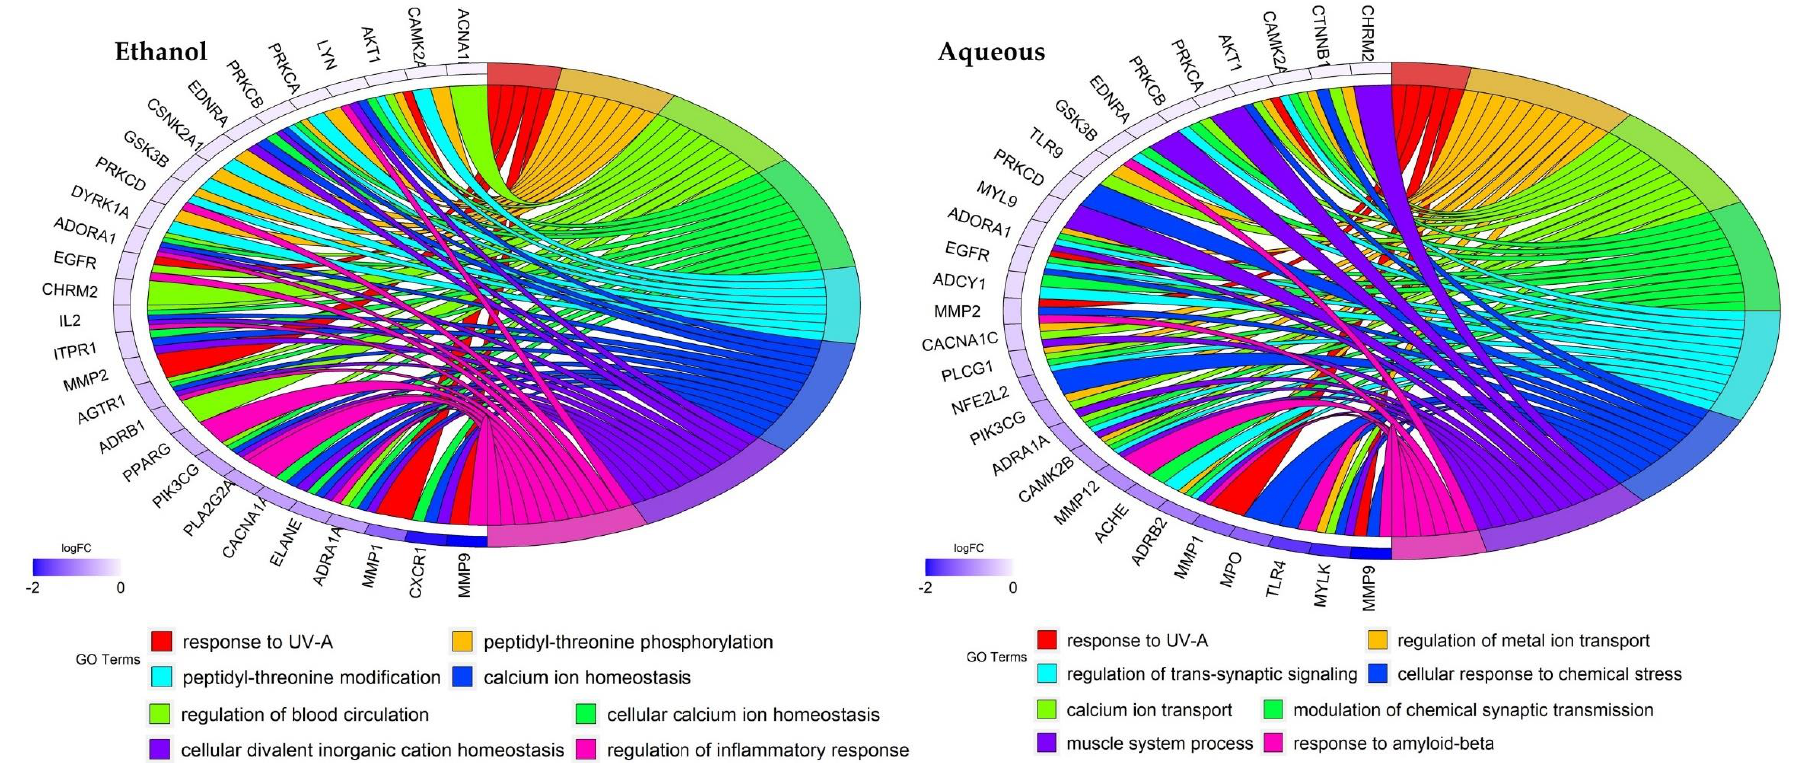
Figure 1. Topological analysis of C. sativus seed extracts with potential protein targets (genes) for respiratory and gastrointestinal illnesses. ( A ) KEGG pathway analysis; ( B ) Gene Ontology (GO) enrichment analysis; BP: biological process; CC: cellular compartments; MF: molecular functions; ( C ) KEGG pathway enrichment of target genes on a map; ( D ) GO biological process enrichment of target genes on a map; ( E ) GO Chord plot analysis of target gene enrichment in GO terms.